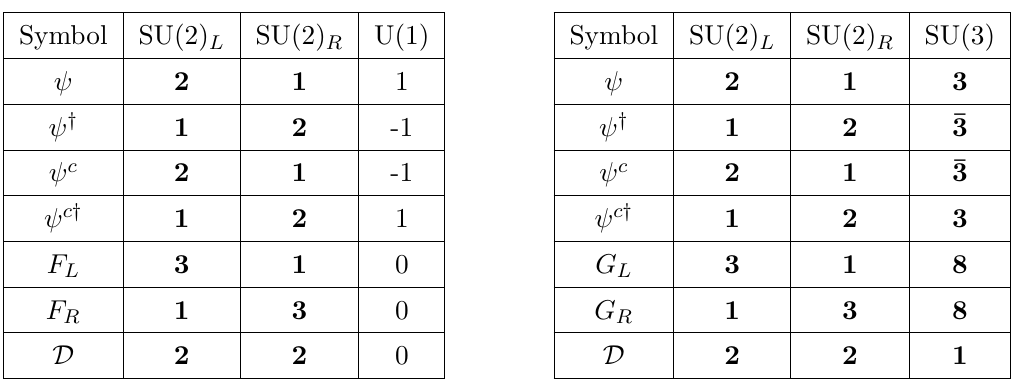
Table 1 . Left: the irreducible representations of the Lorentz and gauge group for the objects out of which our e(cid:11)ective Lagrangian is built. The normalization of the U(1) charge is moot, since we are only making singlets in the bilinear sector. Right: same as the left-hand table, but for an SU(3) gauge